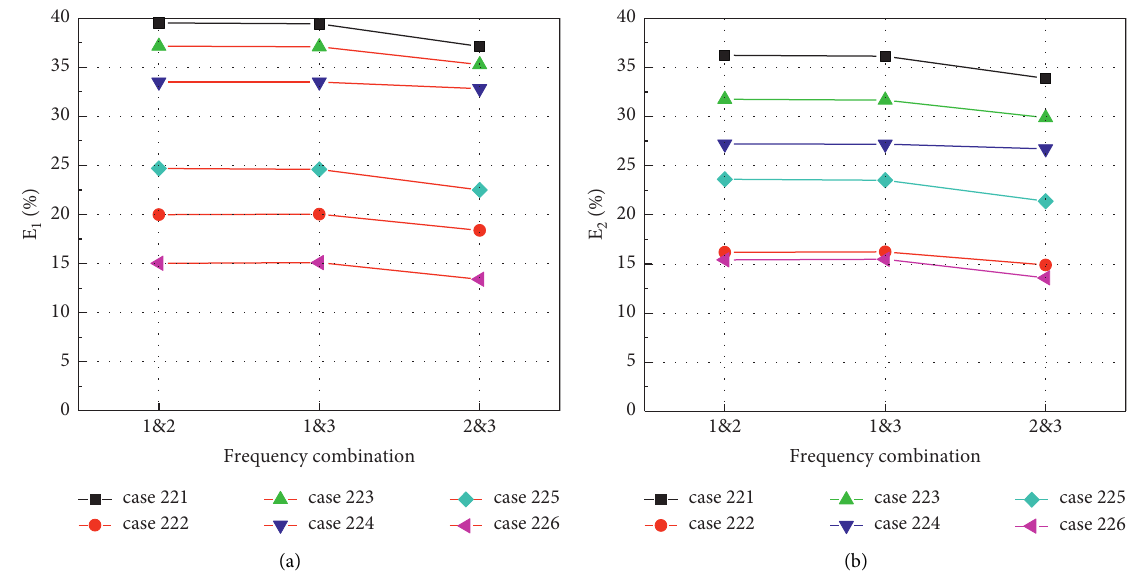
Figure 12: Calculation errors of the first story displacement by using NP-RD (PGA � 0.2g): (a) E1 and (b) E2.